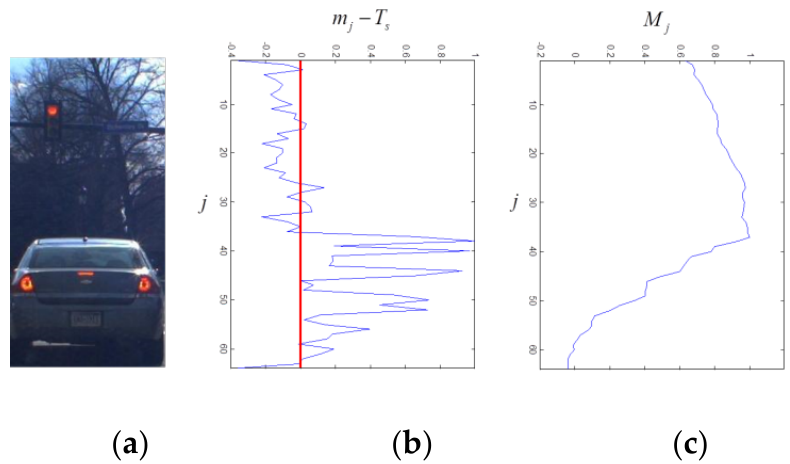
Figure 7. The result of estimating symmetry: ( a ) is the hypothesized window; ( b ) is the symmetry in terms of j ; and ( c ) is the accumulated symmetry from bottom to top p I “ 8, J “ 64 q